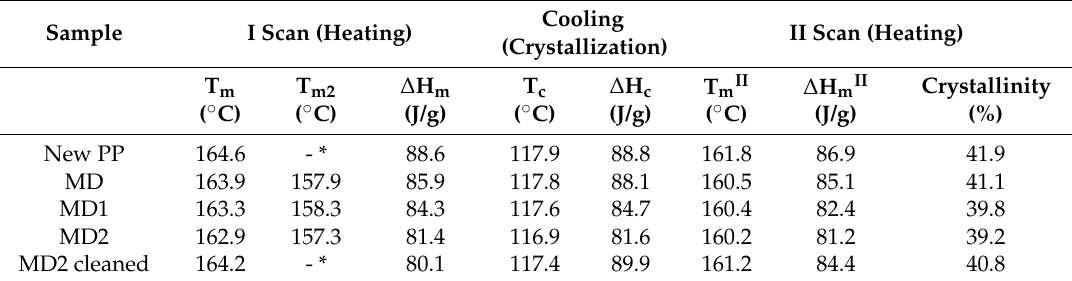
Table 1. The results of DSC analysis. MD2 cleaned—the external (degraded) layer of membrane was